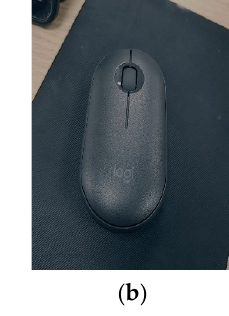
Figure 2. ( a ) Red Pepper with Anthracnose; ( b ) Non ‐ Crop Image.